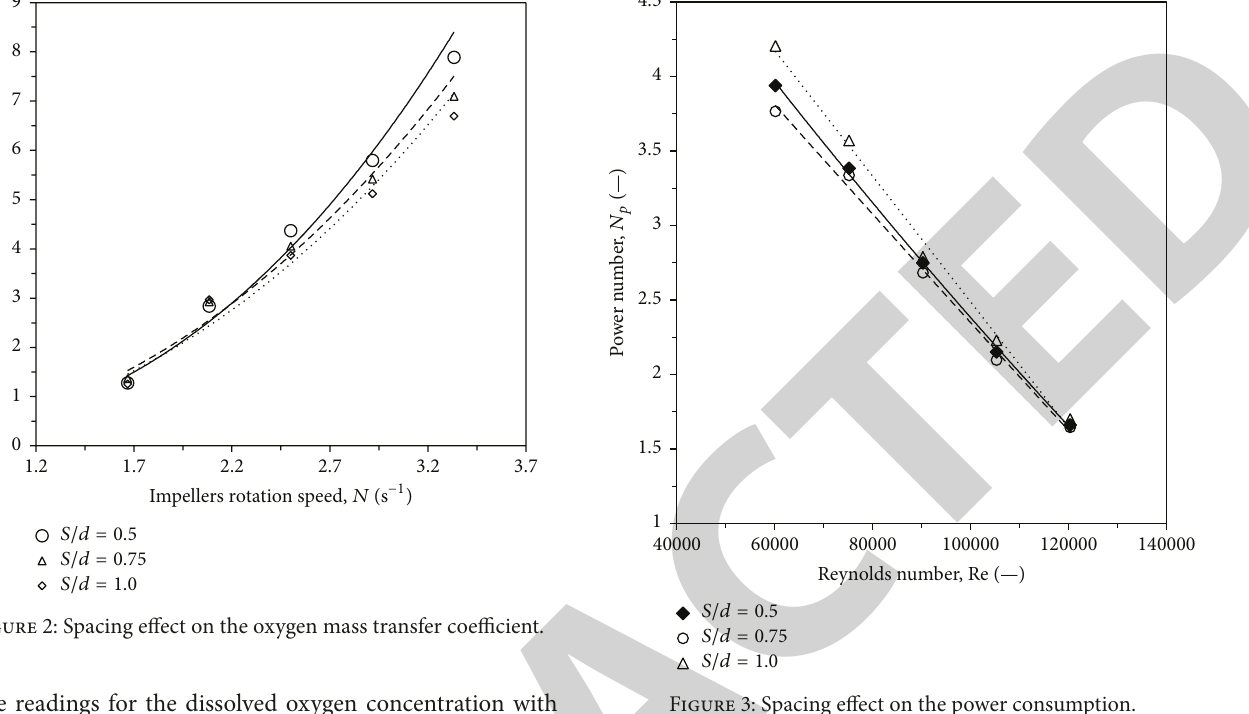
Figure 3: Spacing effect on the power